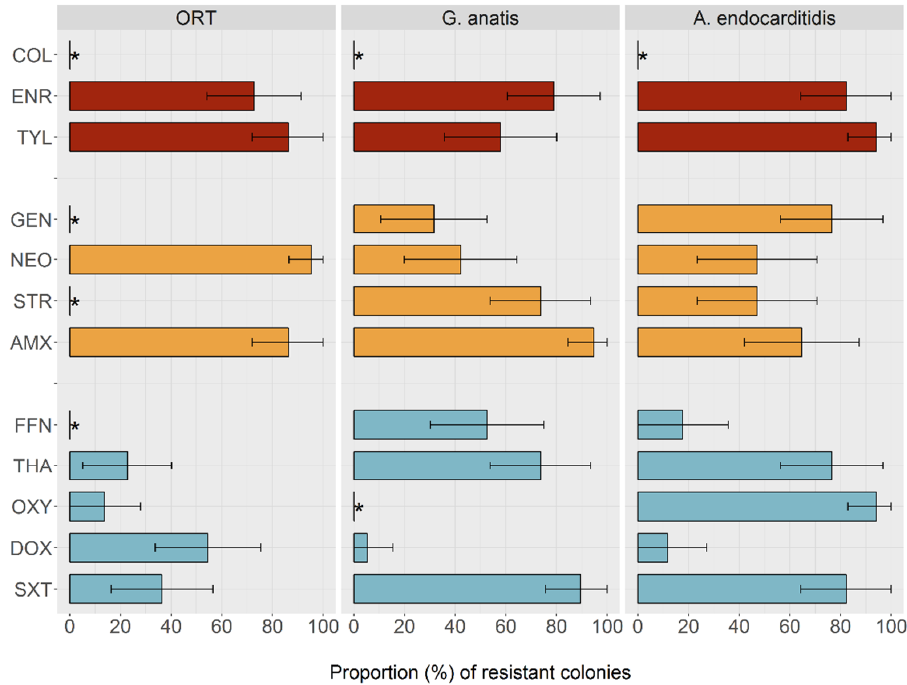
Figure 1. Estimated prevalence of presumptive non-wild phenotypes with regards to 12 antimicrobials among Ornithobacterium rhinotracheale (ORT), G. anatis , and A. endocarditidis isolates from Mekong Delta chicken flocks. Bars indicate percent of isolates that are fully resistant, with 95% binomial confidence intervals drawn around these percentages. Red = highest priority, orange = high priority, blue = highly important antimicrobial according to the WHO. Key: COL = colistin, ENR = enrofloxacin, TYL = tylosin, GEN = gentamicin, NEO = neomycin, STR = streptomycin, AMX = amoxicillin, FFN = florfenicol, THA = thiamphenicol, OXY = oxytetracycline, DOX = doxycycline, SXT = co-trimoxazole. * Tentative epidemiological cut-offs (TECOFFs) could not be established.